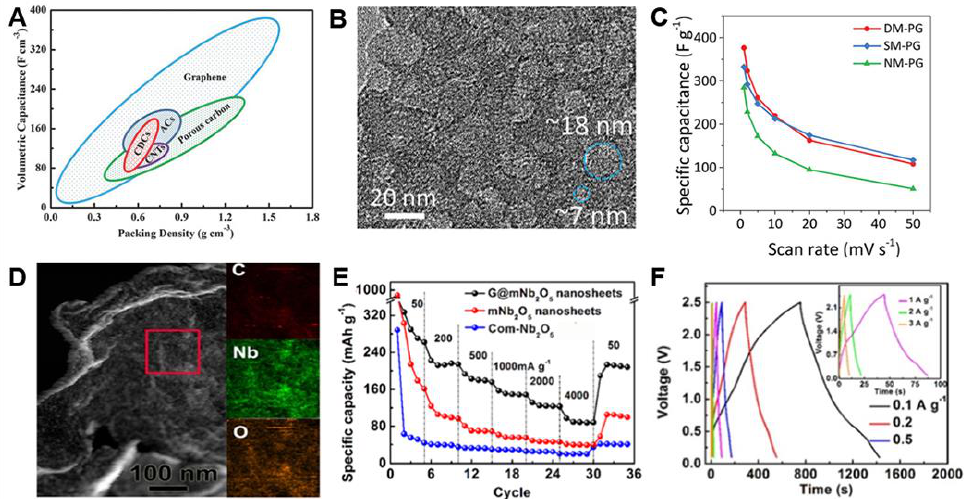
Figure 8. ( A ) Volumetric capacitance and packing density of different carbon electrodes. Reprinted with permission from Ref. [22], Copyright (2018) John Wiley and Sons. ( B ) TEM image of DM-PG nanosheets with dual mesopores of 7 and 18 nm. ( C ) Specific capacitance as a function of scan rate. ( B – C ) Reprinted with permission from Ref. [133], Copyright (2020) John Wiley and Sons. ( D ) STEM image of G@mNb 2 O 5 nanosheets and the corresponding energy-dispersive X-ray spectroscopy (EDX) analysis of C, Nb, and O. ( E ) Rate performance of G@mNb 2 O 5 , mNb 2 O 5 nanosheets and commercial-Nb 2 O 5 electrodes. ( F ) Charge/discharge performance of G@mNb 2 O 5 //AC hybrid supercapacitor at various current densities from 0.1 to 3 A g −1 . ( D – F ) Reprinted with permission from Ref. [136], Copyright (2017)